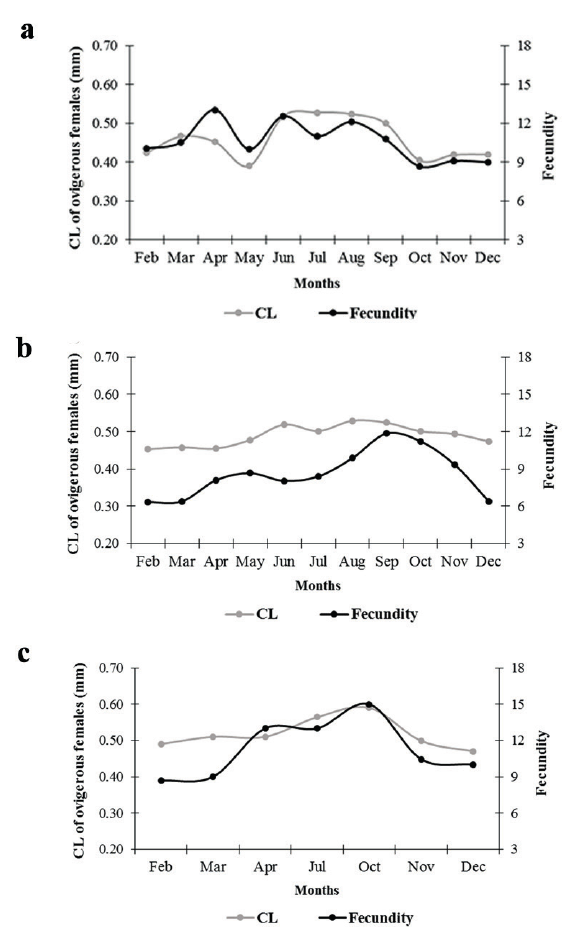
Figure 8 - Cephalothorax length (Cl, in mm) of the ovigerous females of H. pampeana and monthly mean fecundity (eggs/ female) during 2006 in ( a ) site 1, ( b ) site 2 and ( c ) site